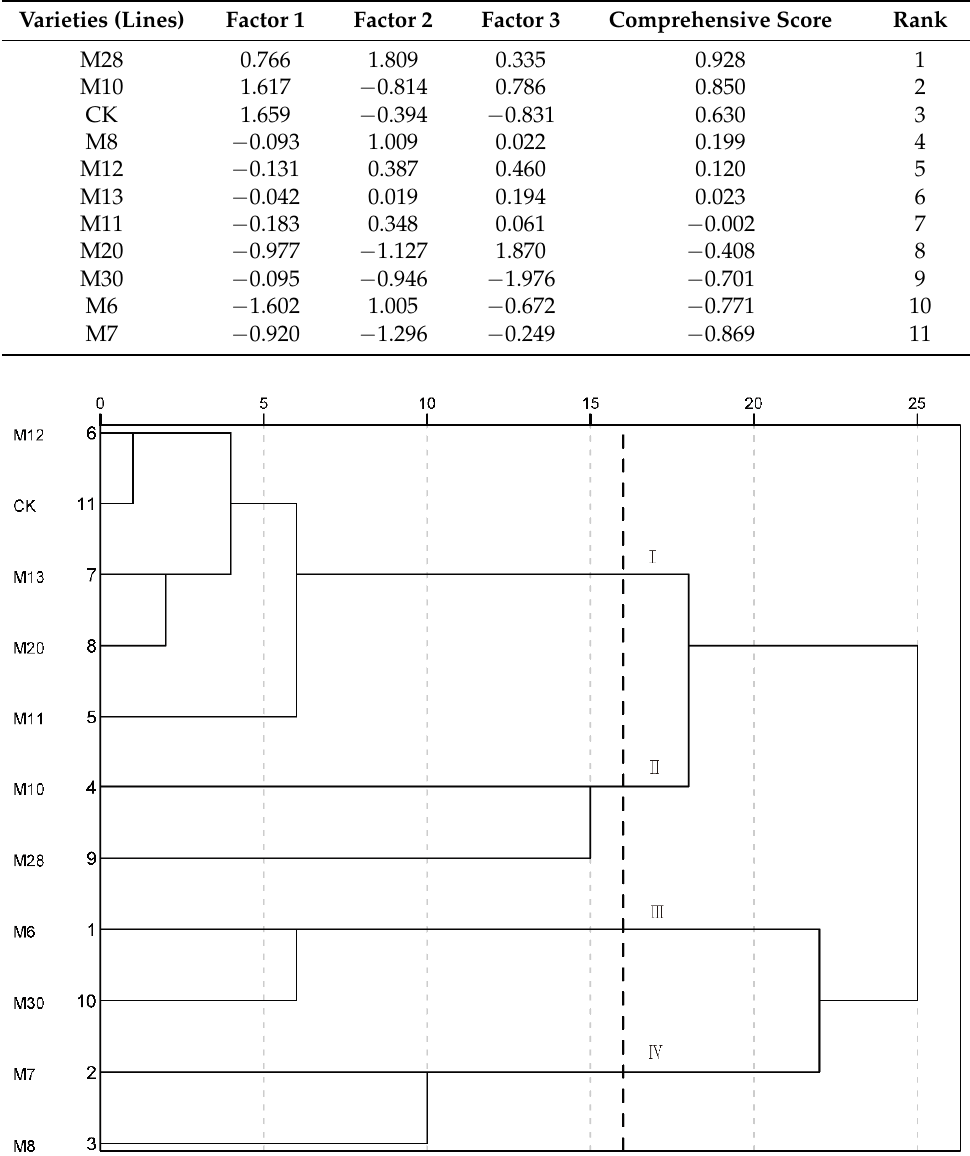
Figure 4. Cluster analysis of fruit quality for wild A. eriantha